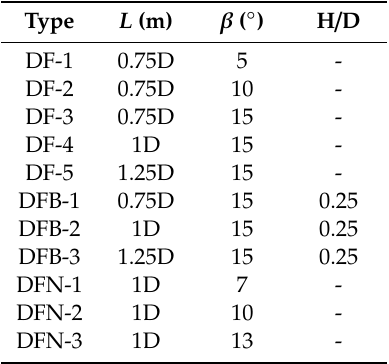
Table 1. Design parameters of di ff